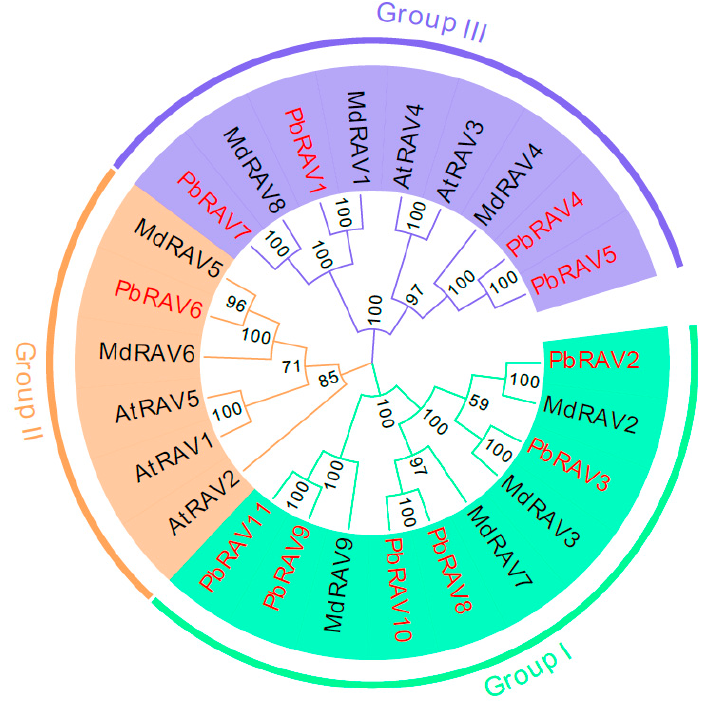
Figure 1. Phylogenetic tree constructed with the neighbor-joining method using RAV TFs domains in P. bretschneideri , M. domestica , and Arabidopsis . The tree was divided into three groups (Groups I, II, and III).